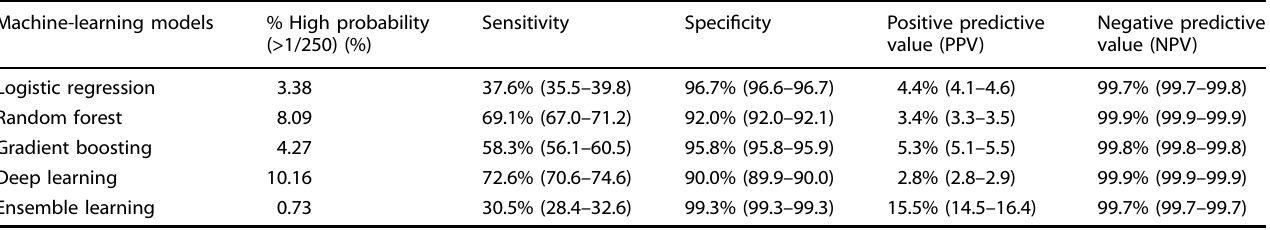
Table 2. Sensitivity, speci fi city, positive predictive and negative values for machine-learning models for detecting familial hypercholesterolaemia in the validation cohort ( n =